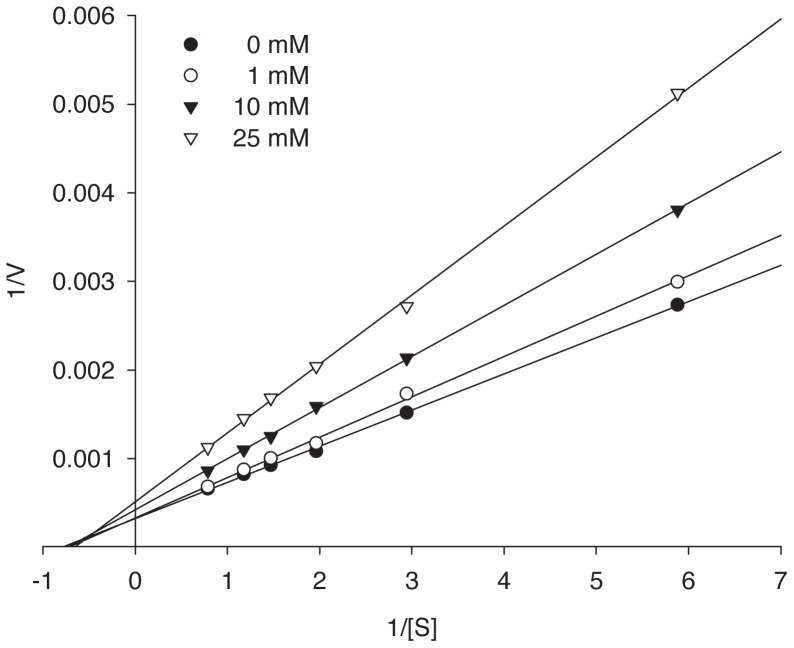
Lineweaver-Burk linearization of PepX inhibition by H-L-Phe-L-Pro-OH (H-Ala-Pro-pNA as substrate; each point represents the average of triplicate measurements; the standard deviation was <5%).